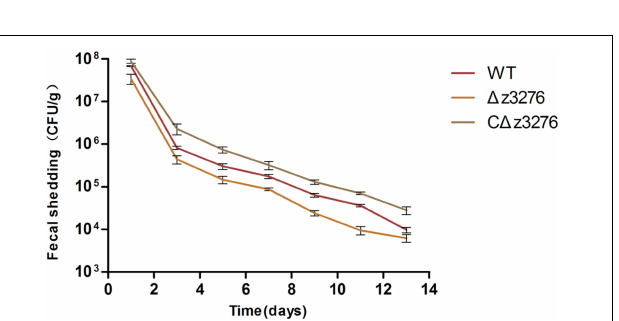
FIGURE 5 | The ability of (cid:49) z3276 to invade IPEC-J2 cells was decreased compared with the wild-type strain. Ceftriaxone (10 µ g/mL) and kanamycin (100 µ g/mL) were added to ensure that only intracellular bacteria were obtained. The WT strain adhesion index was assumed to be 100%. The results shown are the means ± SEM of three independent experiments. ∗∗ Indicates extreme significance at P < 0.01.